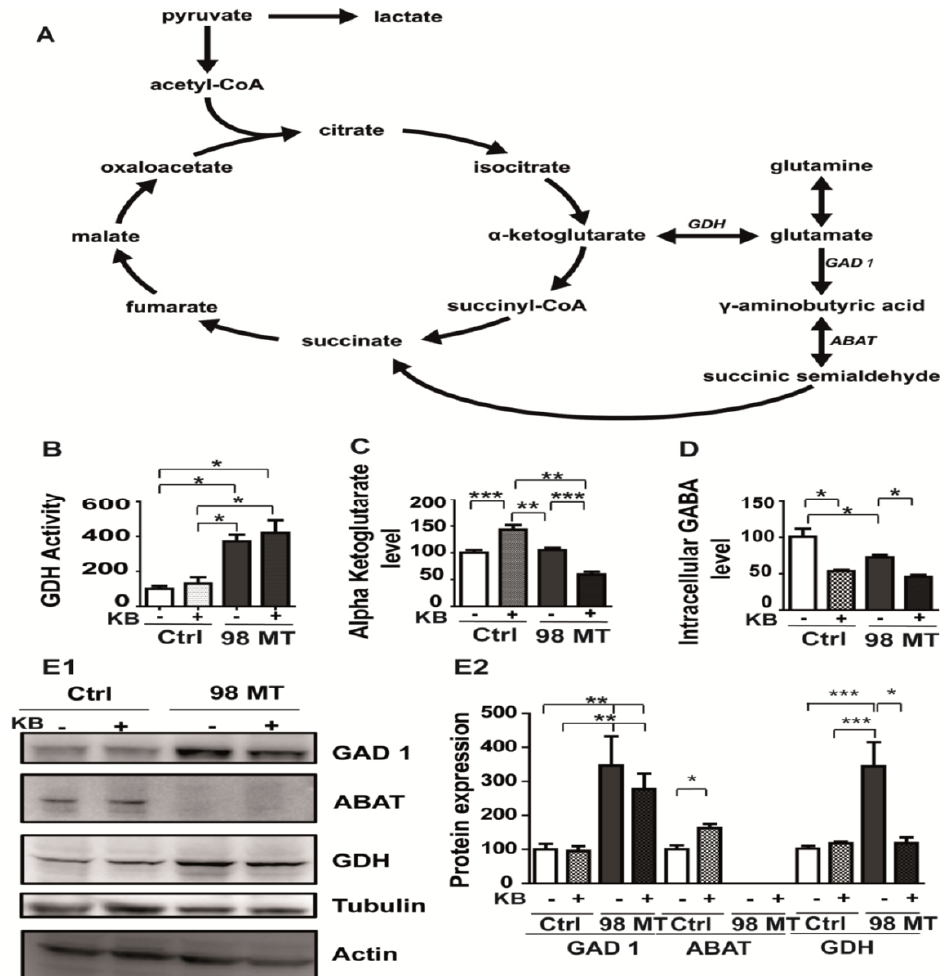
Figure 6. The Glutamate and GABA metabolic pathways are altered in MELAS cells. ( A ) Graphical representation of the glutamate pathway and TCA cycle. GAD1 (glutamate decarboxylase), ABAT (4 aminobutyrate transaminase), and GDH (glutamate dehydrogenase). ( B ) Measurement of GDH activity, ( C ) intracellular levels of α KG concentration, and ( D ) intracellular levels of GABA in Ctrl and 98% MT cells, exposed for 48 h with (+) or without ( − ) KB. ( E1 ) Western blots showing GAD1, ABAT, and GDH expression profiles in Ctrl and 98% MT cells, treated for 48 h with (+) or without ( − ) KB. ( E2 ) Quantification of GAD1, ABAT, and GDH relative expression related to tubulin and actin in Ctrl and 98% MT cells treated with (+) or without ( − ) KB. Results are presented as the mean ± SEM, relative to Ctrl cells of at least 4 independent experiments. Statistical differences between 98% MT and Ctrl cells are indicated with an asterisk (* p < 0.05; ** p < 0.01; *** p <